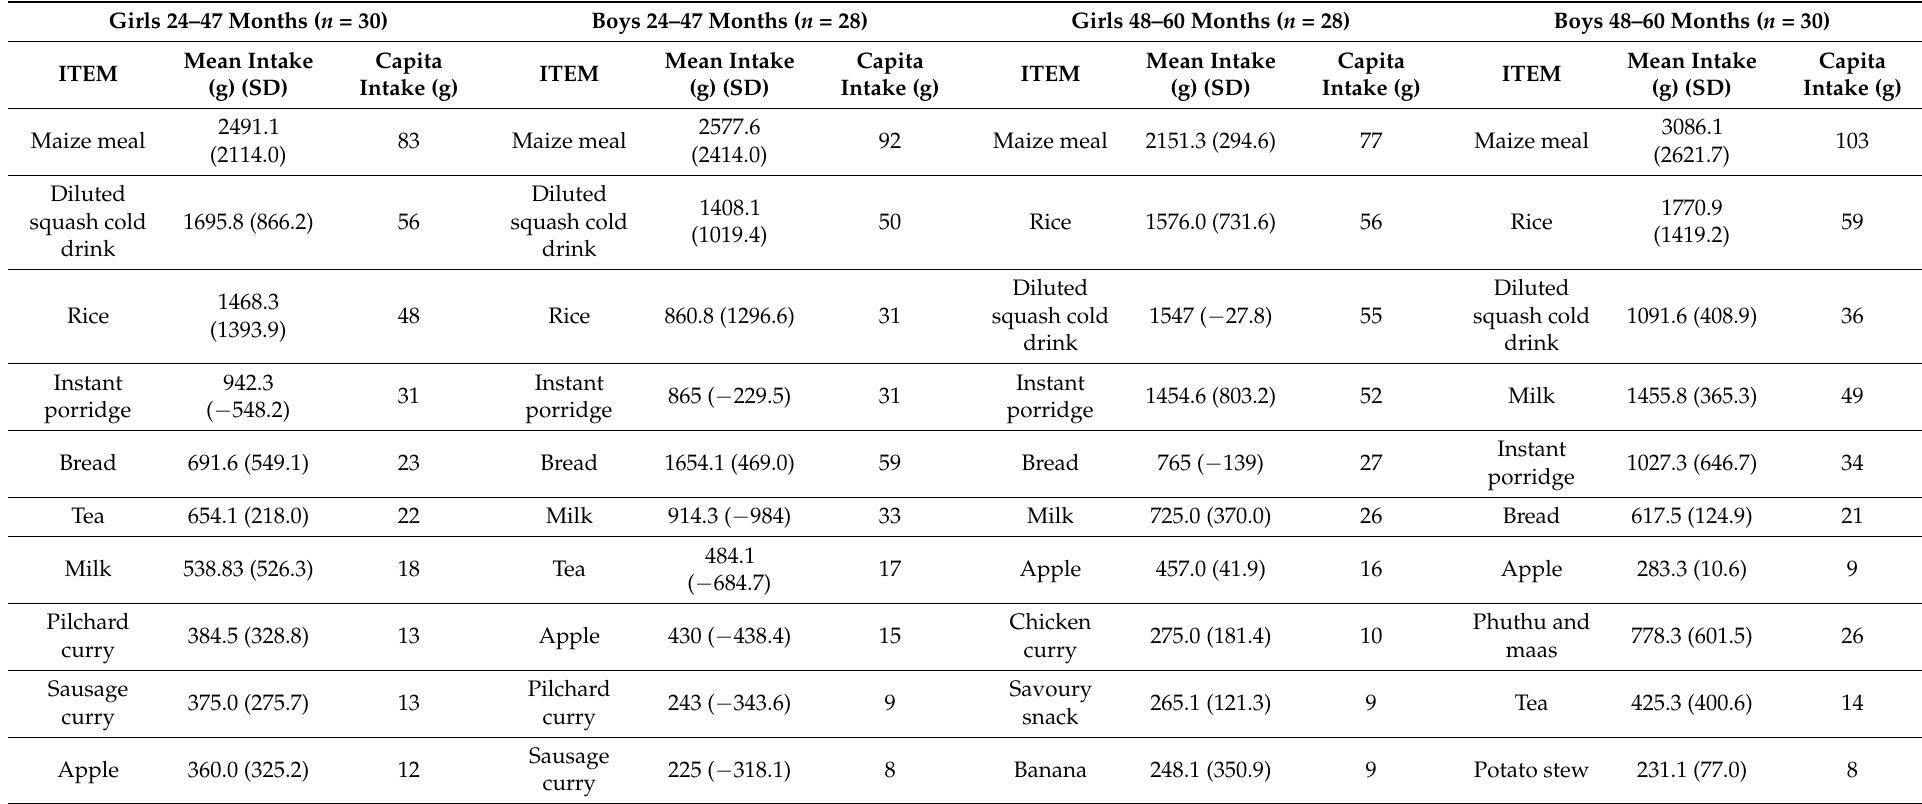
Table 3. Top 10 foods consumed by all girls and boys ( n = 116) between 24 and 60 months as measured by the 24-h food